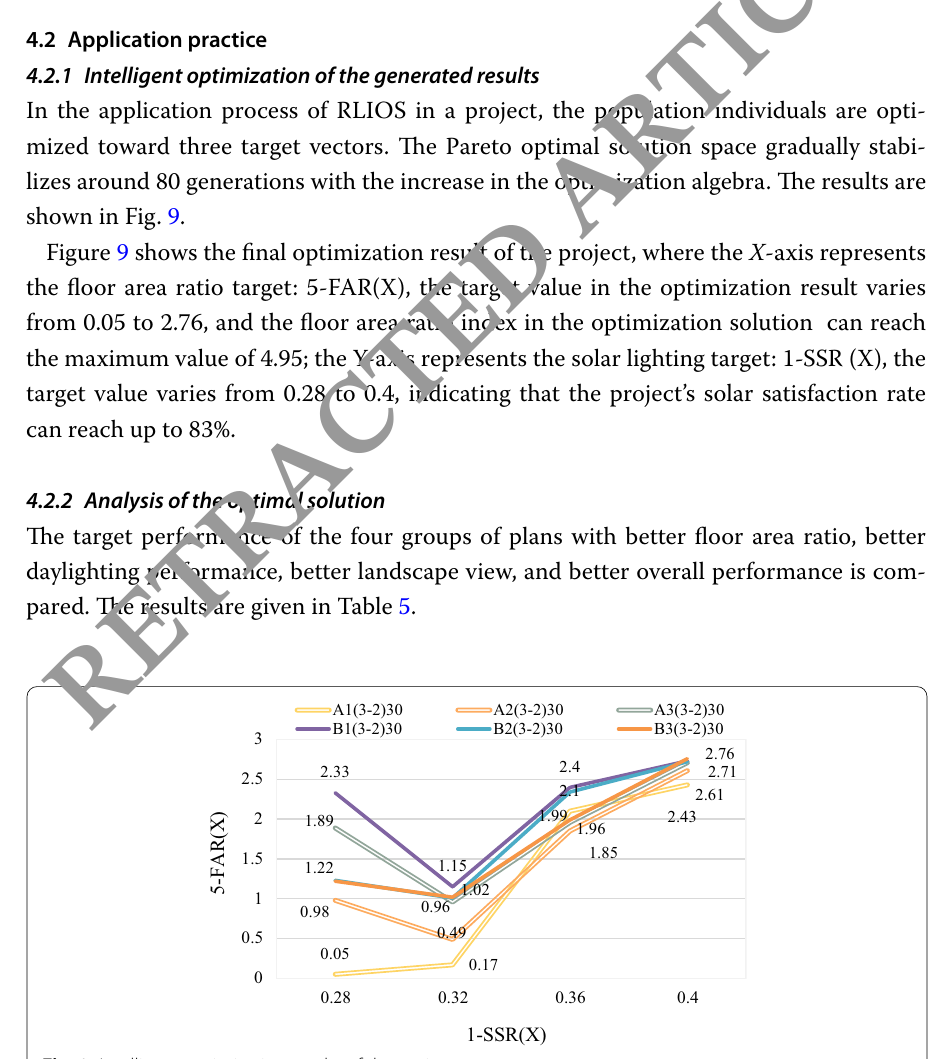
Fig. 9 Intelligent optimization results of the